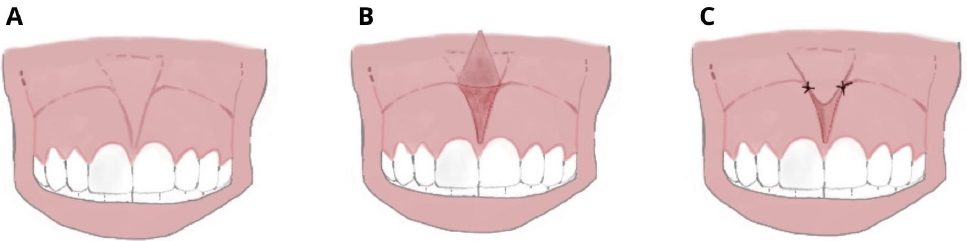
Figure 2. Frenulotomy: ( A ) Hypertrophic superior median frenulum with insertion on the interincisive papilla; ( B ) partial thickness incision disengages frenulum and muscle fibers and does not involve the periosteum; and ( C ) suture and apical repositioning on the labial side.